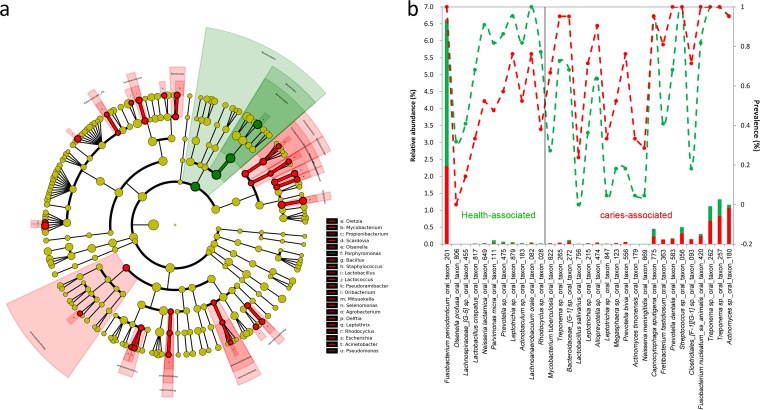
Non-caries- and caries-associated genera (a) and species (b), as determined based on the LEfSe method. The nonparametric factorial Kruskal-Wallis rank sum test was used to detect the taxa with significant differential relative abundance between the healthy group and the caries group at a significance level of 0.05. The relative abundance (the histograms) and prevalence (the dotted lines) of each species are also shown in panel b. Green and red indicate data from healthy and caries groups, respectively.